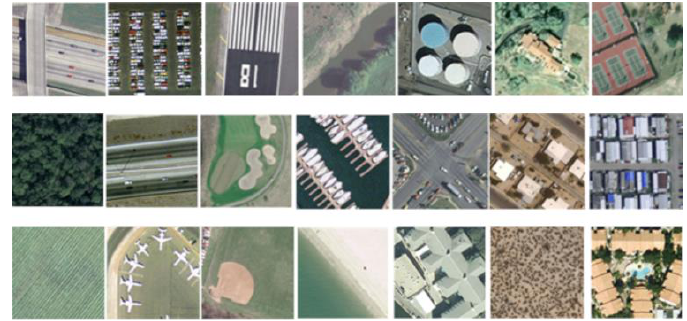
Figure 2. Sample images of UCM dataset.